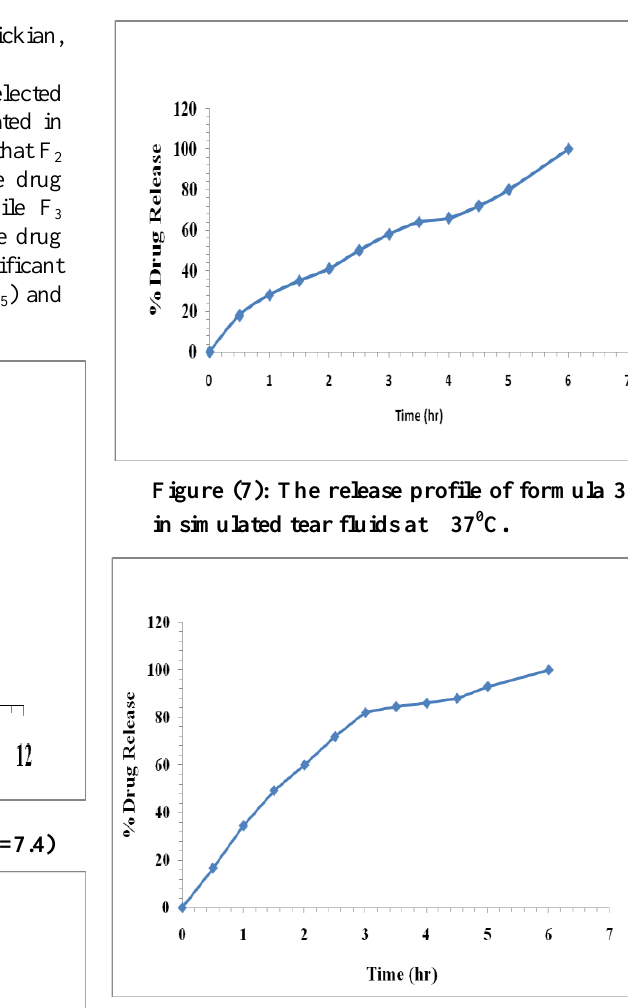
Figure (8): The release profile of formula 5 in simulated tear fluids at 37 0 C